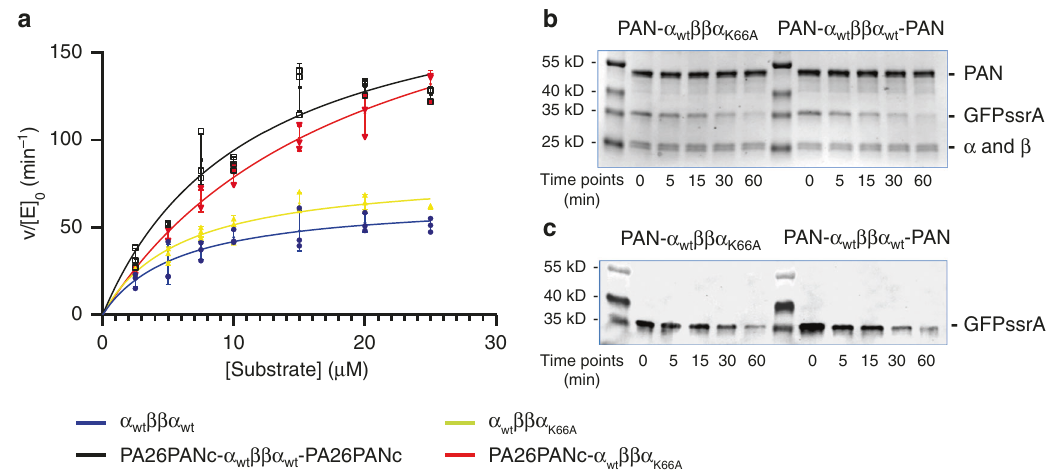
Fig. 2 Substrate degradations by asymmetric proteasomes. a Kinetics of LFP peptide degradation by symmetric (blue) and asymmetric (yellow) 20S CP alone and with double (black) and single (red) activator PA26PANc. Three ( n = 3) biologically independent experiments were carried out. The means are used to derive the curve and the error bars represent standard deviation. b Time course of GFP-ssrA degradation by PAN- α WT ββα K66A and PAN- α ββα – PAGE. The experiment was repeated two times; each produced similar results. c Time course of WT WT -PAN, analyzed by Coomassie Blue stained SDS GFP-ssrA degradation by PAN- α WT ββα K66A and PAN- α WT ββα WT -PAN, analyzed by western blotting with anti-GFP antibody. The MW reference proteins were prestained before applying anti-GFP antibody. The experiment was repeated two times; each produced similar results.